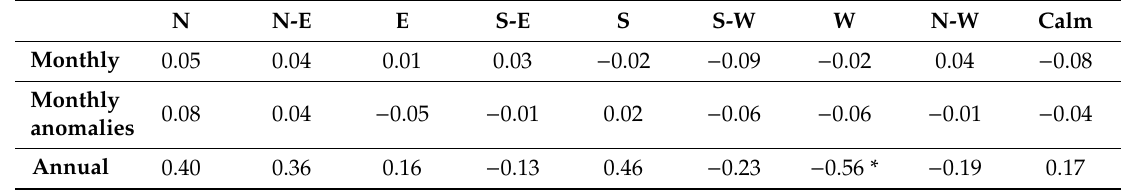
Table 4. As Table 3 but for Romagna.